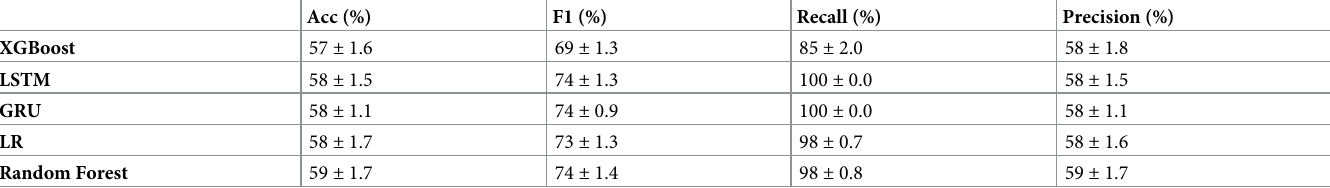
Table 4. This table shows the results of the machine learning models using data from the BRCA 1 gene.